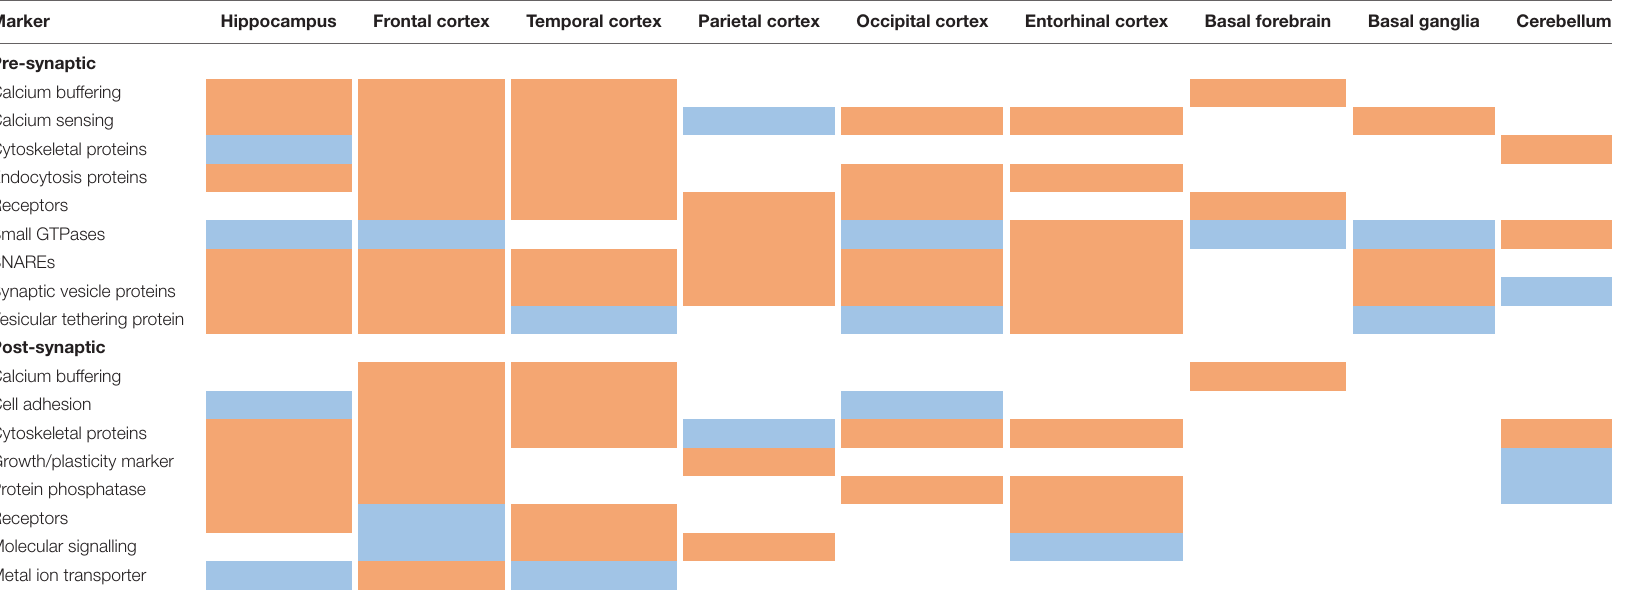
TABLE 1 | Synaptic markers across differentially affected brain regions in AD. Marker Hippocampus Frontal cortex Temporal cortex Parietal cortex Occipital cortex Entorhinal cortex Basal forebrain Basal ganglia Cerebellum